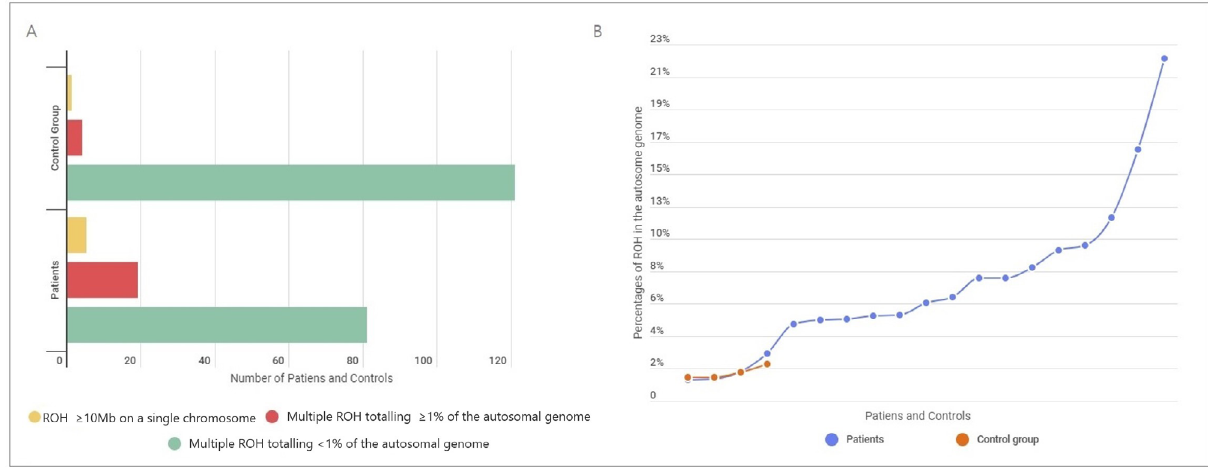
Figure 1 – (A) Number of patients and controls with homozygous regions in the autosomal genome. Patients show a higher prevalence of clinically relevant ROH (single ≥10Mb and multiple ≥1%), as expected (5/265 versus 1/289 and 19/265 versus 4/289, respectively). However, multiple ROH, that do not exceed 1% of the autosomal genome and that unlikely have clinical relevance, are more frequent in the control group (81/265 versus 121/289); (B) Values referring to percentages of homozygosity in the autosomal genome of 19 patients and four controls whose ROH sum exceeds 1%. The observed ROH ≥10Mb on a chromosome and multiple ROH totaling ≥ 1% of the genome should be considered with potential clinical relevance.